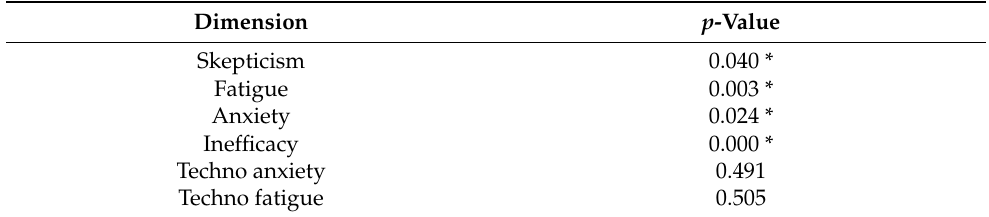
Table 6. Chi-square test p -value for differences in gender proportions by dimension (factor) of the RED-TIC